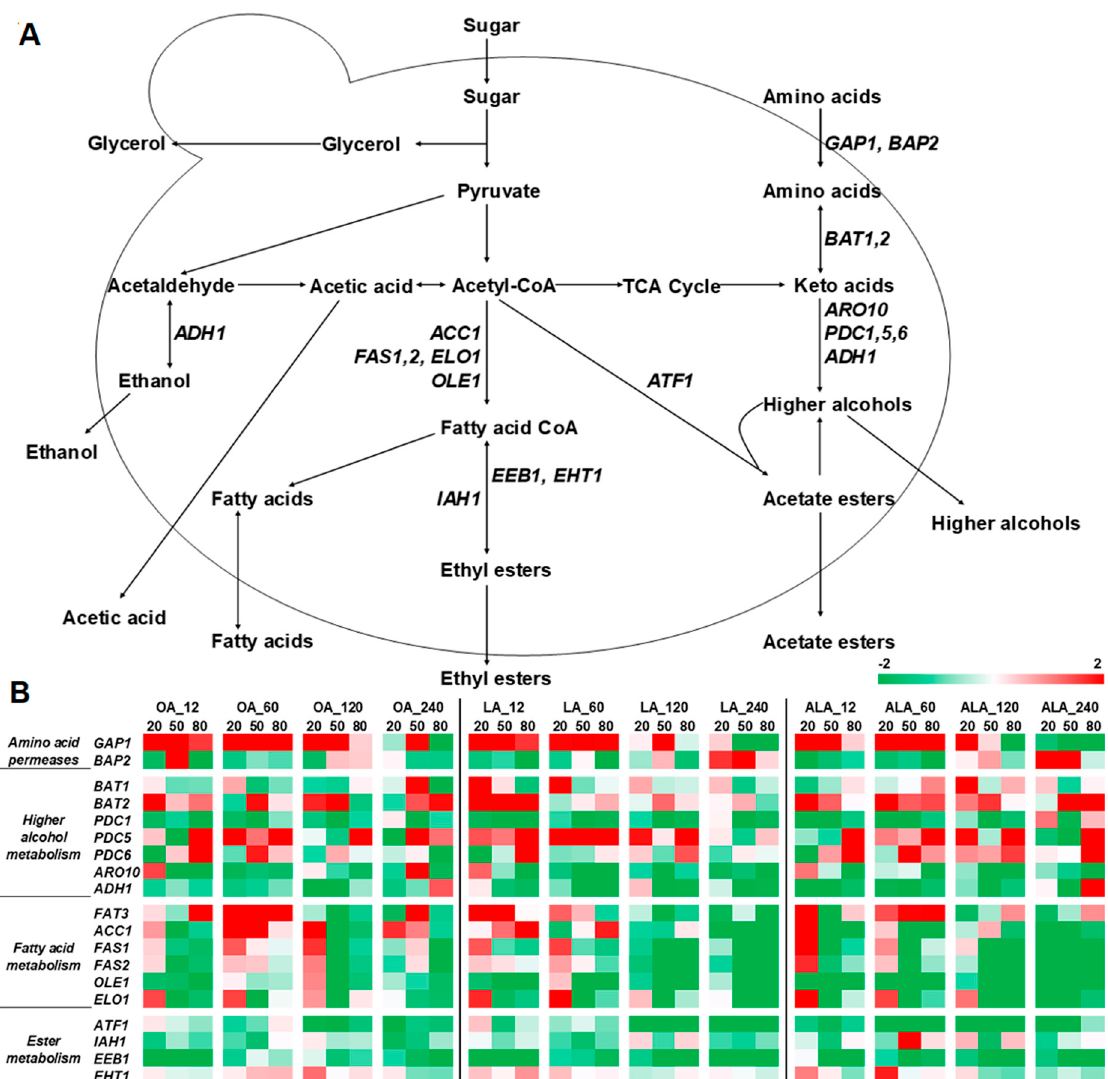
Figure 5. ( A ) Metabolic pathway involved in volatile compounds formation. Yeast genes that are involved in each step in the different pathways are shown in italic. ( B ) Comparative analysis of genes expressions of yeast in different treatments with that in the Control at each fermentation stage (sugar consumption 20%, 50%, and 80%) were conducted. The ratios were obtained using the corresponding Control as reference (red up-regulated and green down-regulated).